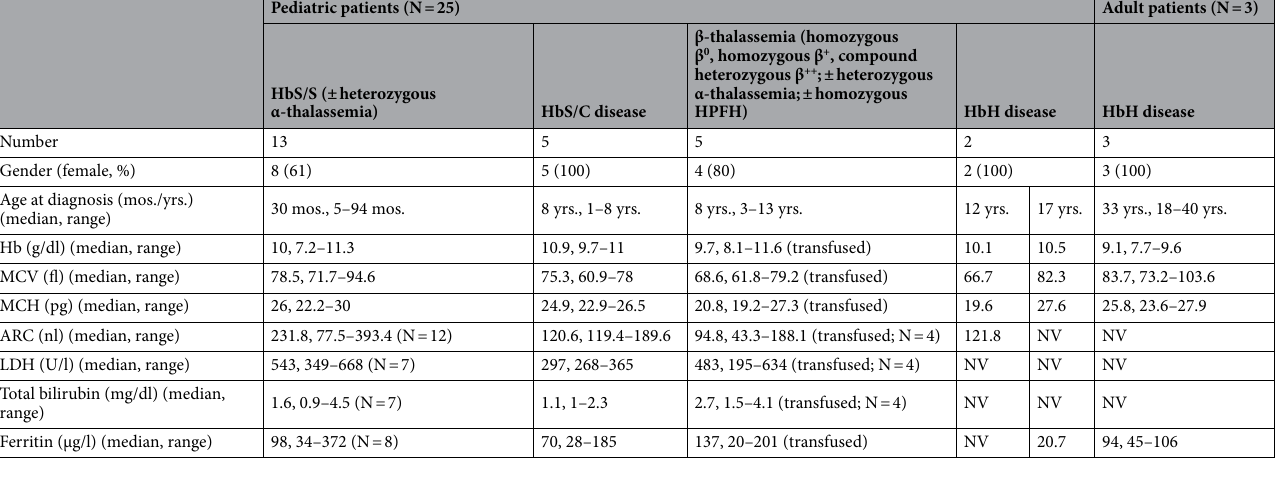
Table 4. Disease states in pediatric and adult patients (N = 28). ARC absolute reticulocyte count, Hb hemoglobin, HPFH hereditary persistence of fetal hemoglobin, LDH lactate dehydrogenase, MCH